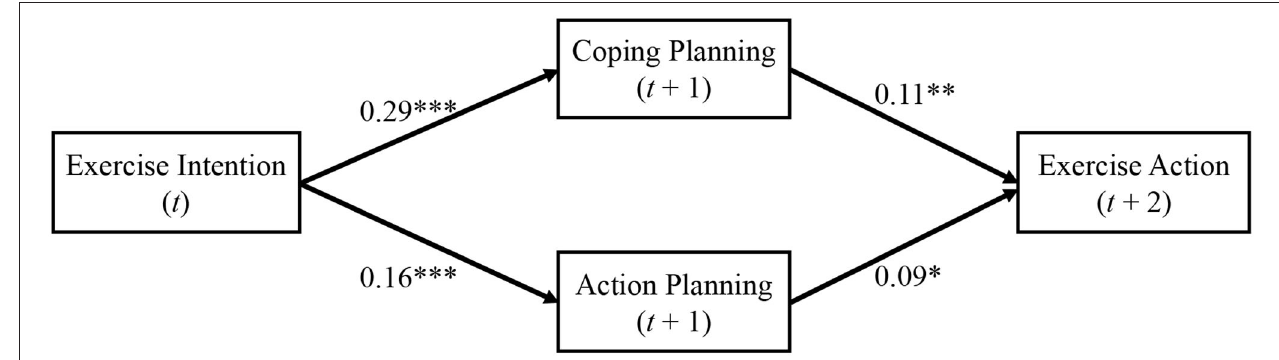
FIGURE 2 | The results of mediation model. * p < 0.05, ** p < 0.01, *** p < 0.001; t , t + 1, and t + 2 indicate that the independent variables were measured at time t , the mediators were measured at lagged time t + 1, and the dependent variable measured at lagged time t + 2.